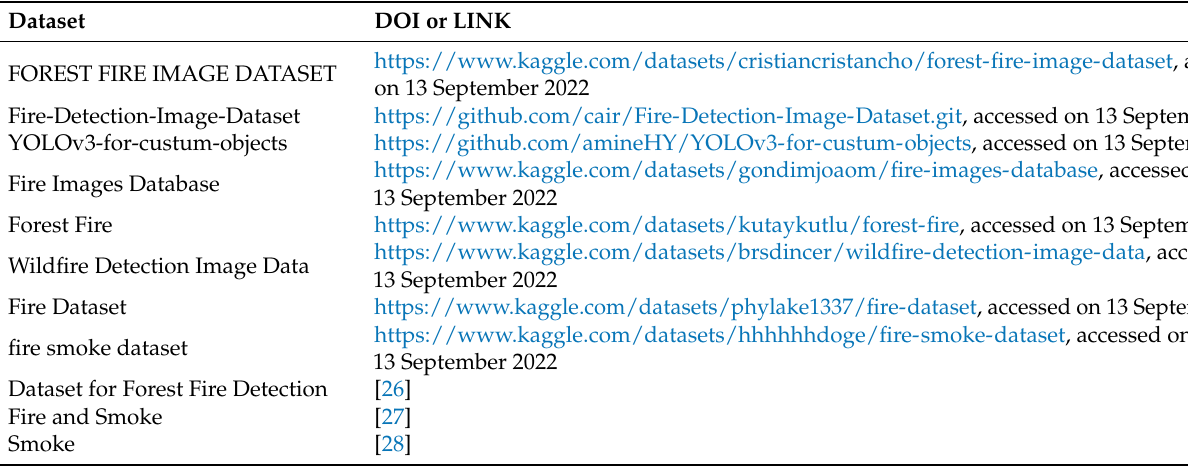
Table 1. Image sources.